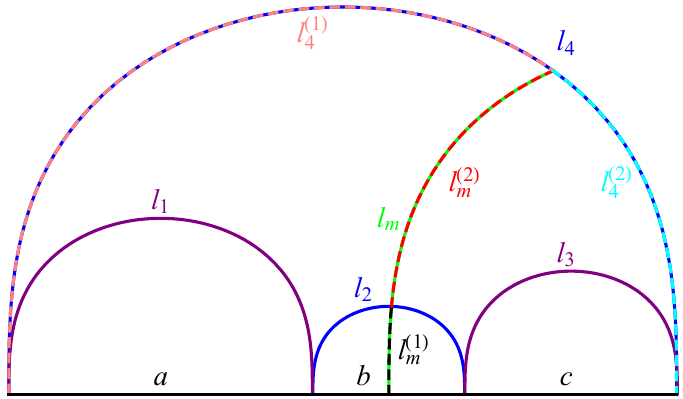
Figure 14 . A cartoon for the proof of inequality (A.3). Two purple curves are minimum surfaces with disconnected entanglement wedge, and two blue curves are minimum surfaces with connected entanglement wedge. l 1 ; l 2 ; l 3 ; l 4 are the lengths of the curves of the geodesic C a ; C b ; C c ; C a;b;c re- spectively. The green curve is the geodesic intersecting with C b and C a;b;c from which the minimum cross-section is obtained. The length of the green curve is l m and the EoP of con(cid:12)guration ( a; b; c ) is l (2) m